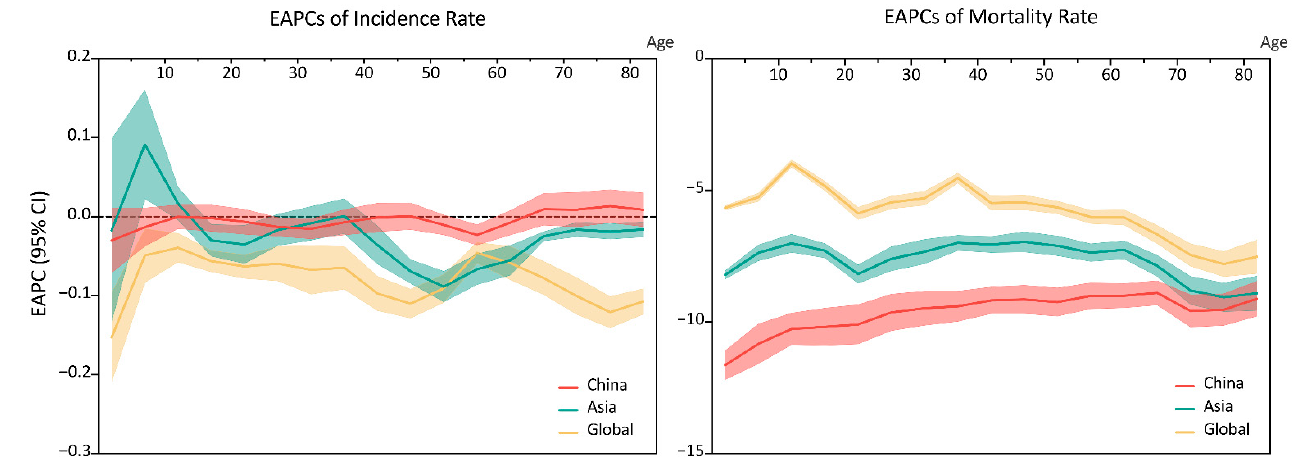
Figure 4. EAPCs of age-specified incidence and mortality rates of upper respiratory infections from 1990 to 2019, in China, Asia, and the rest of the globe. EAPC, estimated annual percentage change.